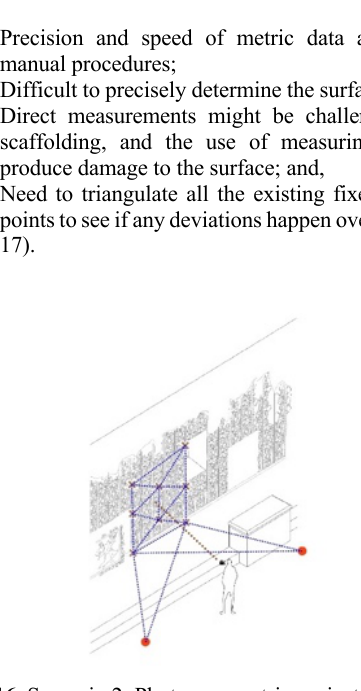
Figure 16 . Scenario 2: Photogrammetric project with manual survey. Image by CIMS © GCI 2019.